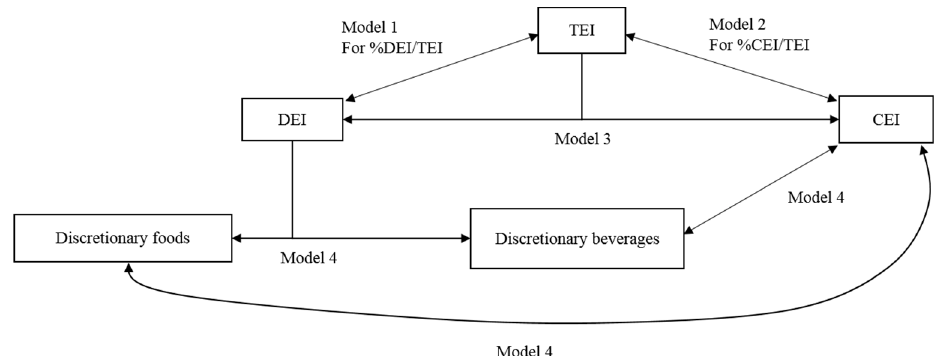
Figure 1. The relationship between various dietary components assessed in the current study using simultaneous-equation random effects models. TEI, total energy intake; DEI, discretionary energy intake; CEI, core energy intake.